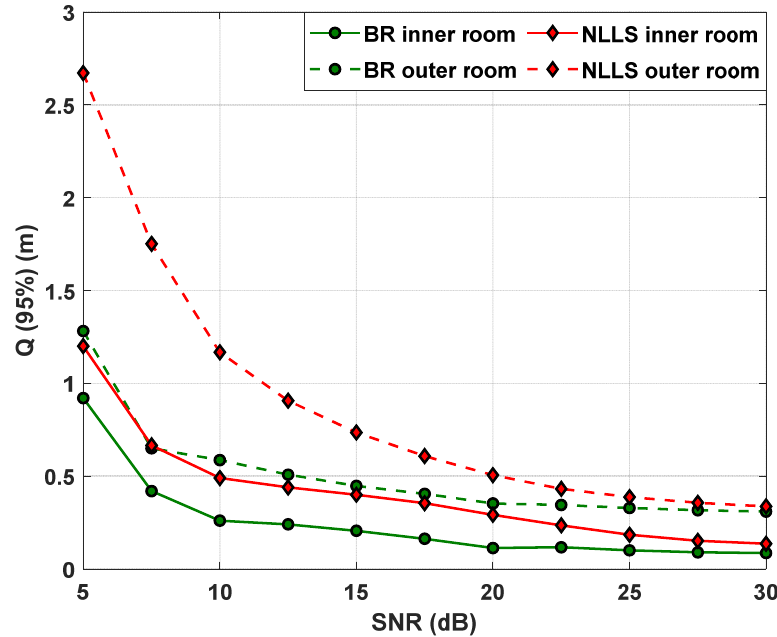
Figure 9. The measured 95% quantile function for NLLS and BR.